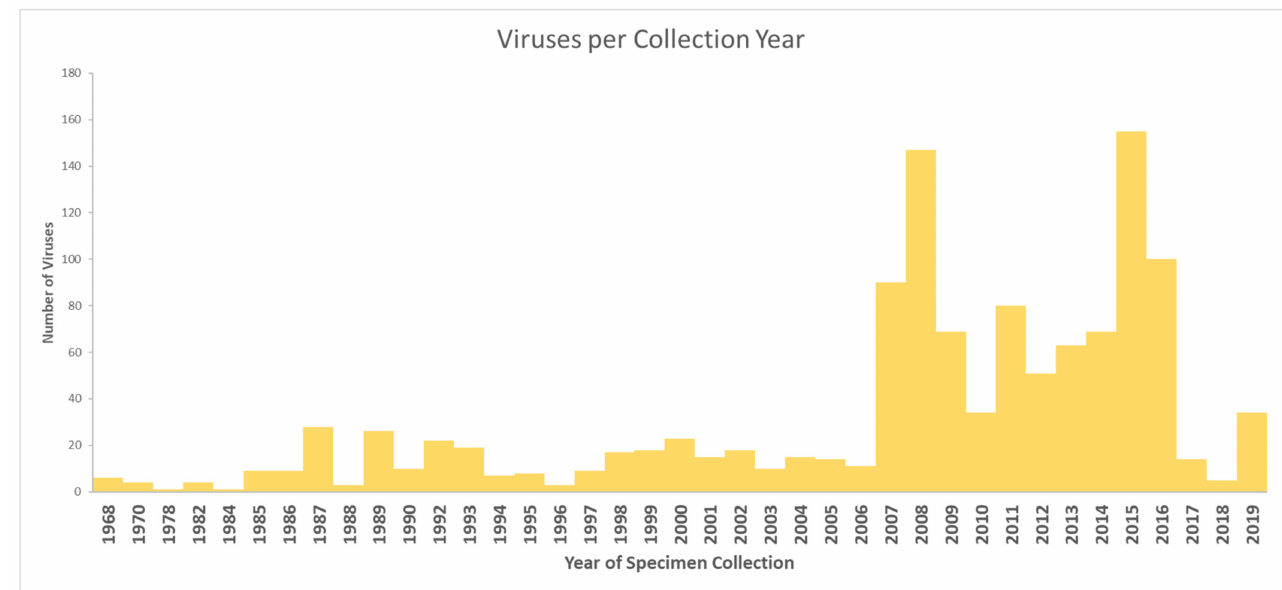
Figure 2. Number of published virus sequences by year of specimen collection (DBatVir [1]).